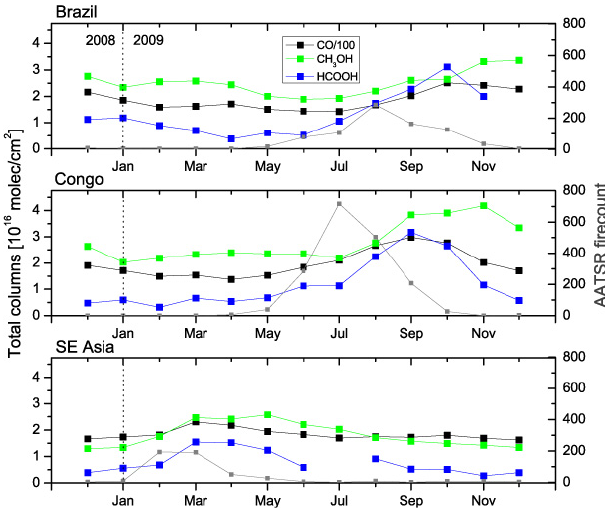
Fig. 11. Time series of methanol (green curve), formic acid (blue curve) and carbon monoxide (black curve) monthly mean total columns for three different areas associated with biomass burn- ing (Brazil, Congo and SE Asia). Carbon monoxide total columns where divided by 100 for comparison. The left scale and gray curves correspond to the sum of the AATSR fire counts for each